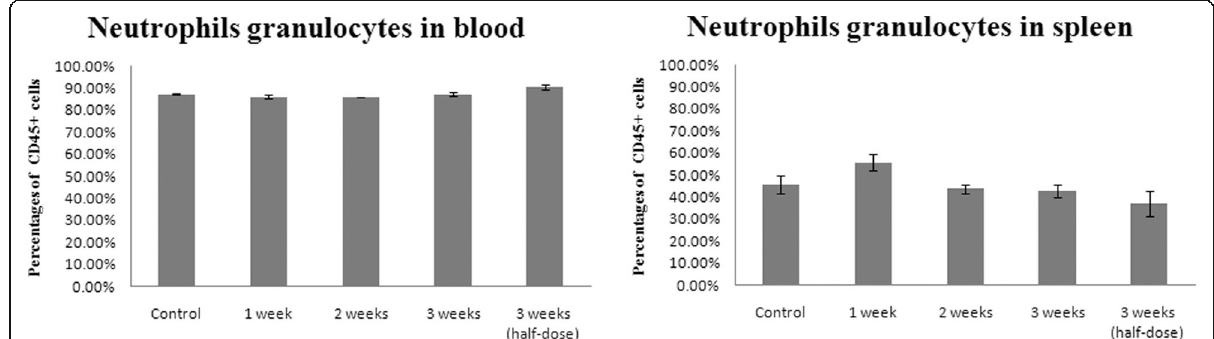
Fig. 5 Statistic results of neutrophils granulocytes in blood and spleen. The time and dose treatment of modified Si-Jun-Zi Decoction was labeled under the columns. The data were shown as mean ± standard error of